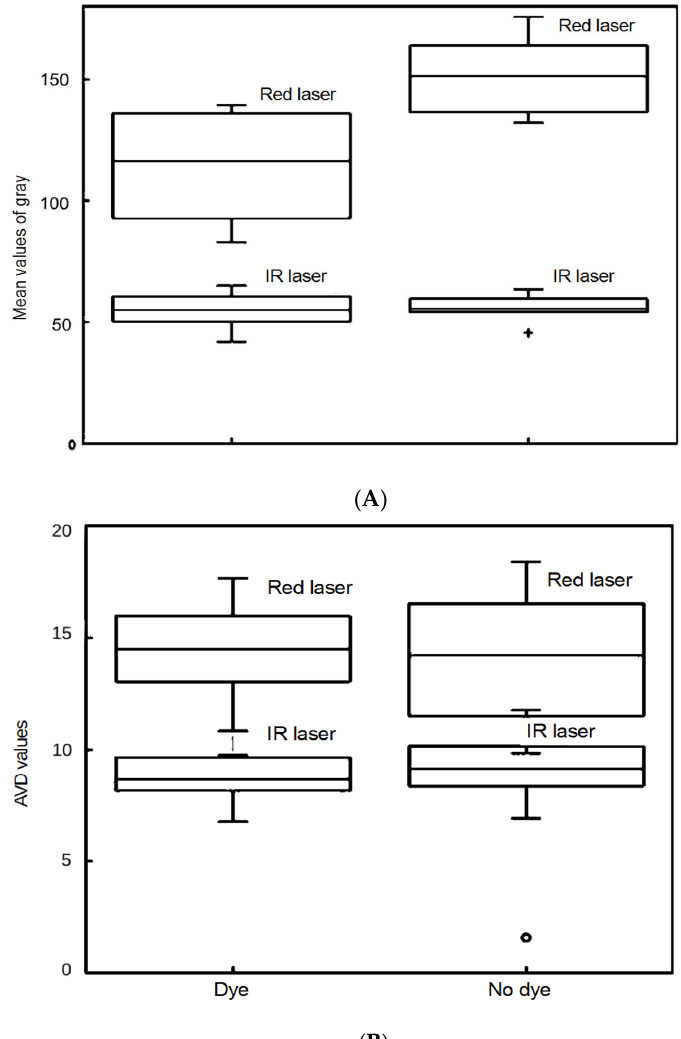
Figure 10. Box plot of ( A ) mean values of light intensity from the speckle histograms and ( B ) AVD values from the tip of the root inside dye and no ‐ dye gels in a glass tube illuminated by red and IR lasers.